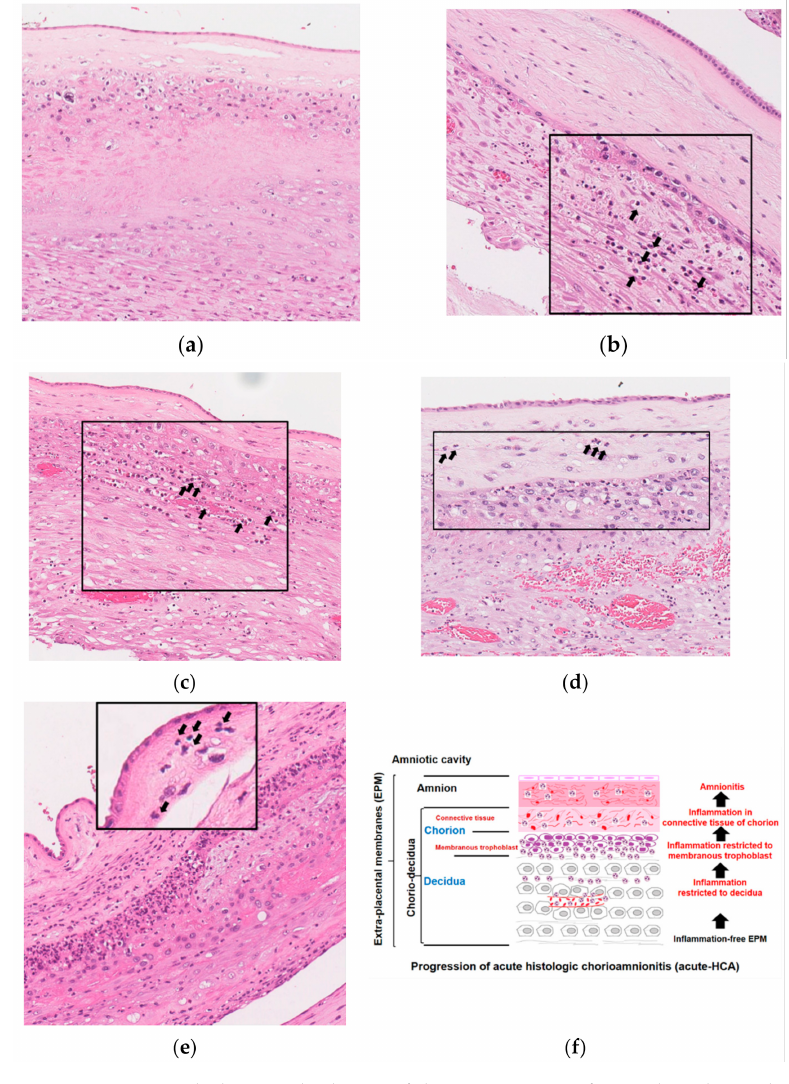
Figure 3. Histopathology and schema of the progression of acute histologic chorioamnionitis (acute- HCA). Hematoxylin and eosin stained histologic sections of extra-placental membrane (EPM) are shown as follows: ( a ) group-0, inflammation-free EPM; ( b ) group-1, inflammation restricted to decidua; ( c ) group-2, inflammation restricted to the membranous trophoblast of chorion and the decidua; ( d ) group-3, inflammation in the connective tissue of chorion but not amnion; ( e ) group-4, amnionitis. These images are based on the magnification setting × 200 and the insets of panels are based on the magnification setting × 400. Some neutrophils are shown in the decidua (group-1) ( b ), the membrane trophoblast of chorion (group-2) ( c ), the connective tissue of chorion ( d ), and amnion ( e ) (see the insets of panels). Black arrows in the insets of panels indicate neutrophils infiltrating into EPM ( b – e ). The schema of the progression of acute-HCA depicts outside-in neutrophils migration in the whole sub-divisions of EPM ( f